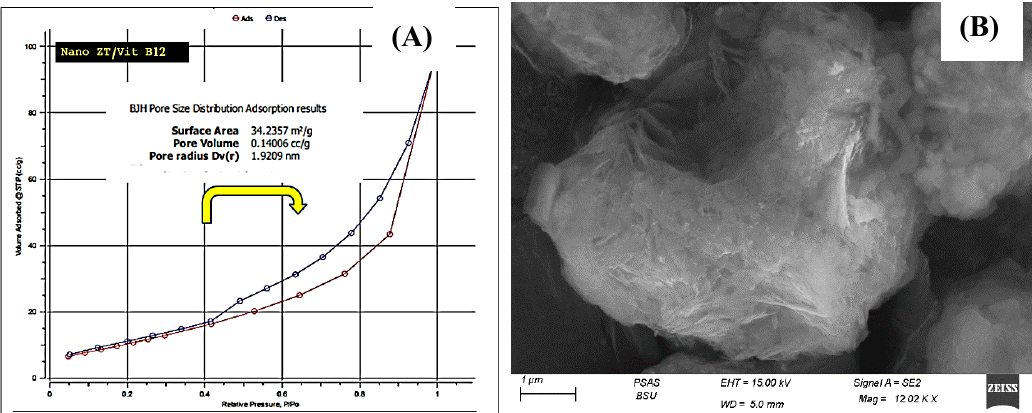
Figure 5. ( A , B ) N 2 adsorption–desorption isotherms and SEM of Nano ZT/Vit B12.